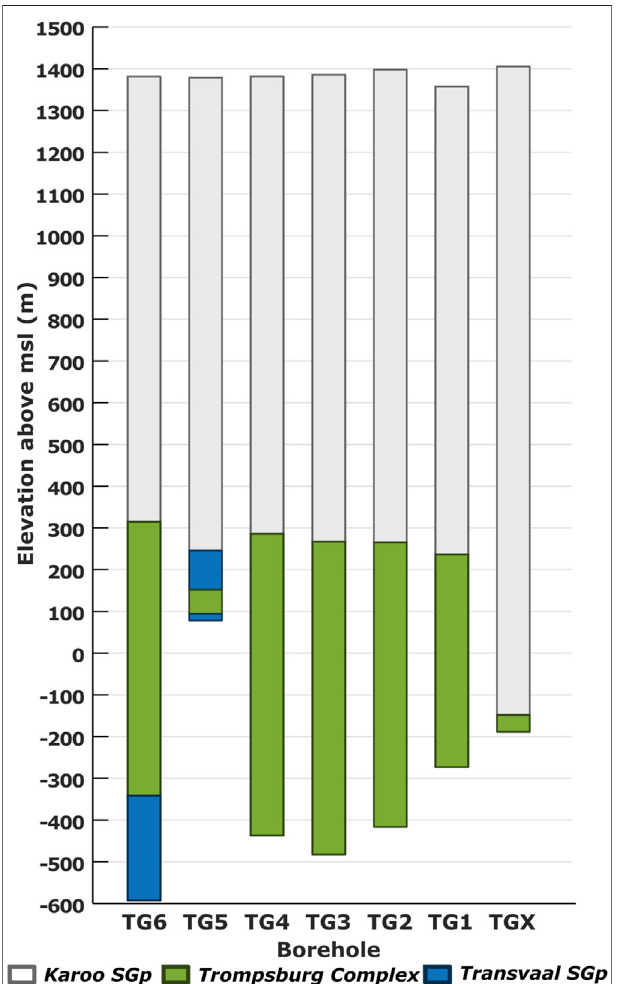
FIGURE 4 | Summary of density measurements of lithologies identi fi ed by Maré and Cole (2006). Bar limits denote maximum and minimum density values and centre lines denote average density values. Note that only one measurement was made on dolerite and dolomite samples.